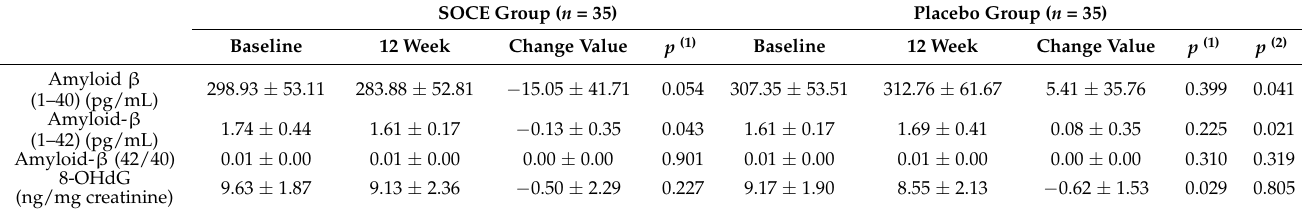
Table 5. Changes in amyloid β and 8-OHdG levels before and after 12 weeks of intake of study